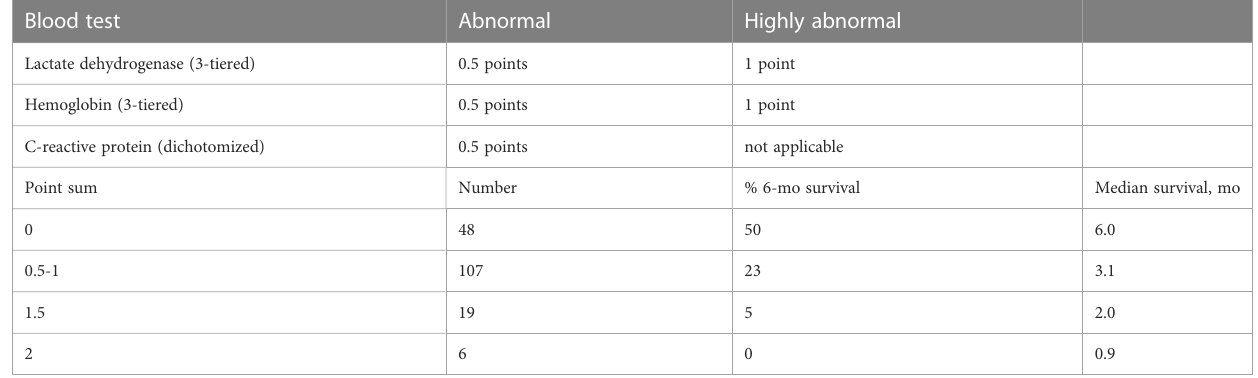
TABLE 3 Modi fi ed LabBM score (point sum 0: 3 normal blood tests).